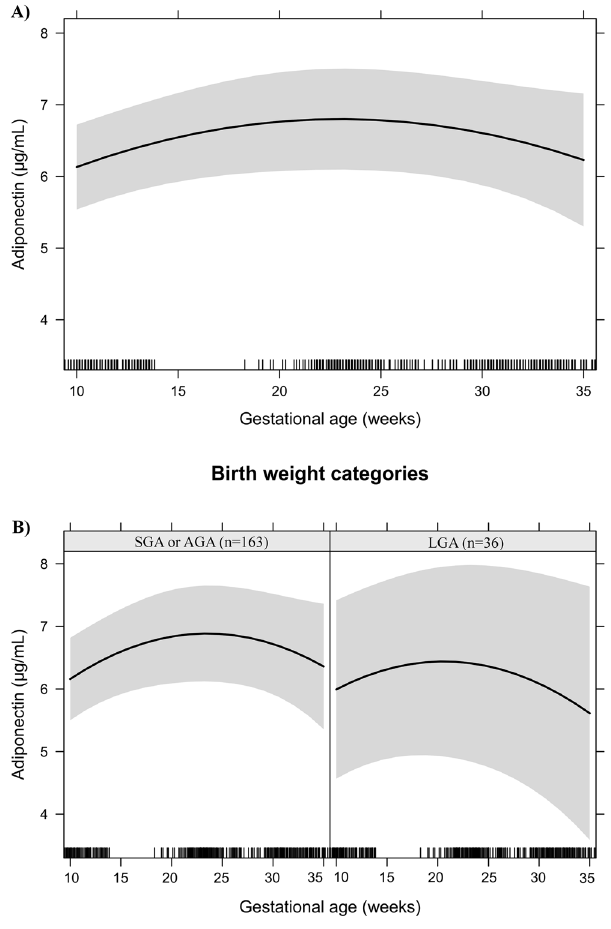
Figure 6. Adiponectin changes during pregnancy in a sample of 199 women and their newborns followed at a public health centre in Rio de Janeiro city, Brazil, 2009–2012. ( A ) Change per gestational week. ( B ) Change per gestational week according to birth weight categories. Note: The models were adjusted for age, education, smoking habit, pre-pregnancy leisure time physical activity, pre-pregnancy energy intake, glycaemia, parity, early pregnancy BMI, gestational weight gain and quadratic gestational age. Data are presented as linear mixed effect coefficient ( β ) and 95% CI. p-value refers to the maximum likelihood estimator. ( A ) Linear gestational age: β = 0.19 (0.03; 0.34), p = 0.018; Quadratic gestational age: β = − 0.004 ( − 0.01; − 0.0003), p = 0.033. ( B ) SGA or AGA - Linear gestational age: β = 0.21 (0.03; 0.39), p = 0.021; quadratic gestational age; β = − 0.004 ( − 0.01; − 0.0002), p = 0.042. LGA - Linear gestational age: β = 0.13 ( − 0.02; 0.29), p = 0.096; gestational age; β = − 0.004 ( − 0.01; 0.0003), p =